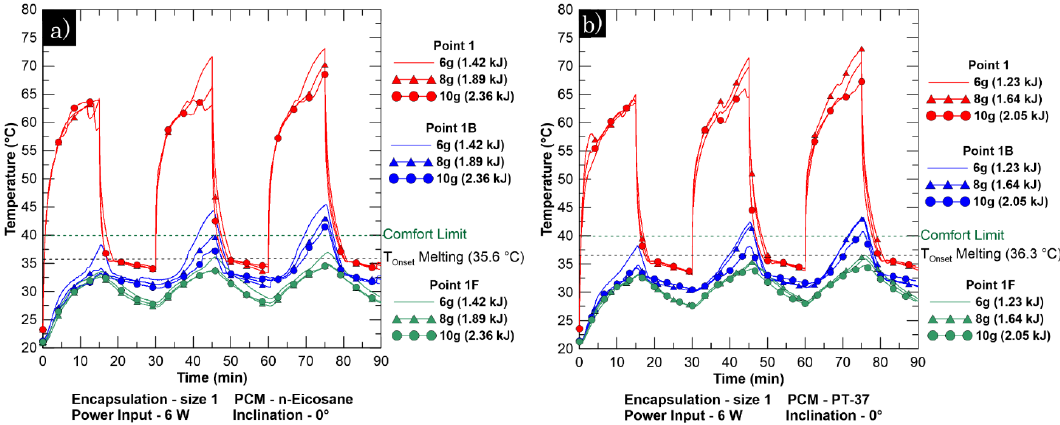
Figure 13. Influence of varying latent heat on the thermal response of the experimental tablet PC at 6 6 W power input and 45 ◦ inclination: ( a ) n -eicosane, and ( b ) W power input and 45° inclination: ( a ) n- eicosane, and ( b ) PT-37.